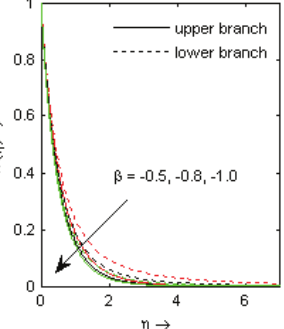
1 , r 0:5 . 2, M 0.5, k 0, ˇ D D D (cid:31) D D (cid:31)